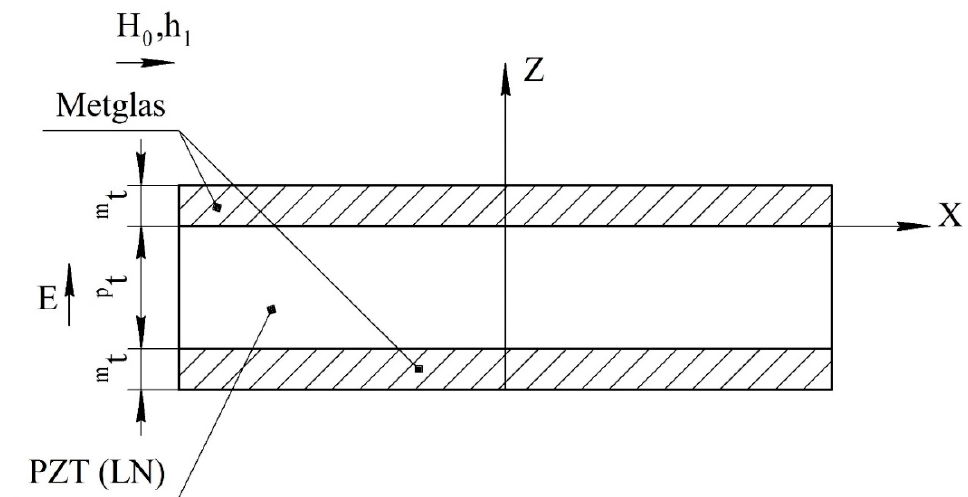
Figure 1. Symmetric tri-layer magnetoelectric composite for the calculation of longitudinal mode. Magnetic fields are parallel to each other and lie in the plane of structure, the electric field is perpendicular to the plane of structure, and p t and m t are the thicknesses of piezoelectric and magnetostrictive layers.